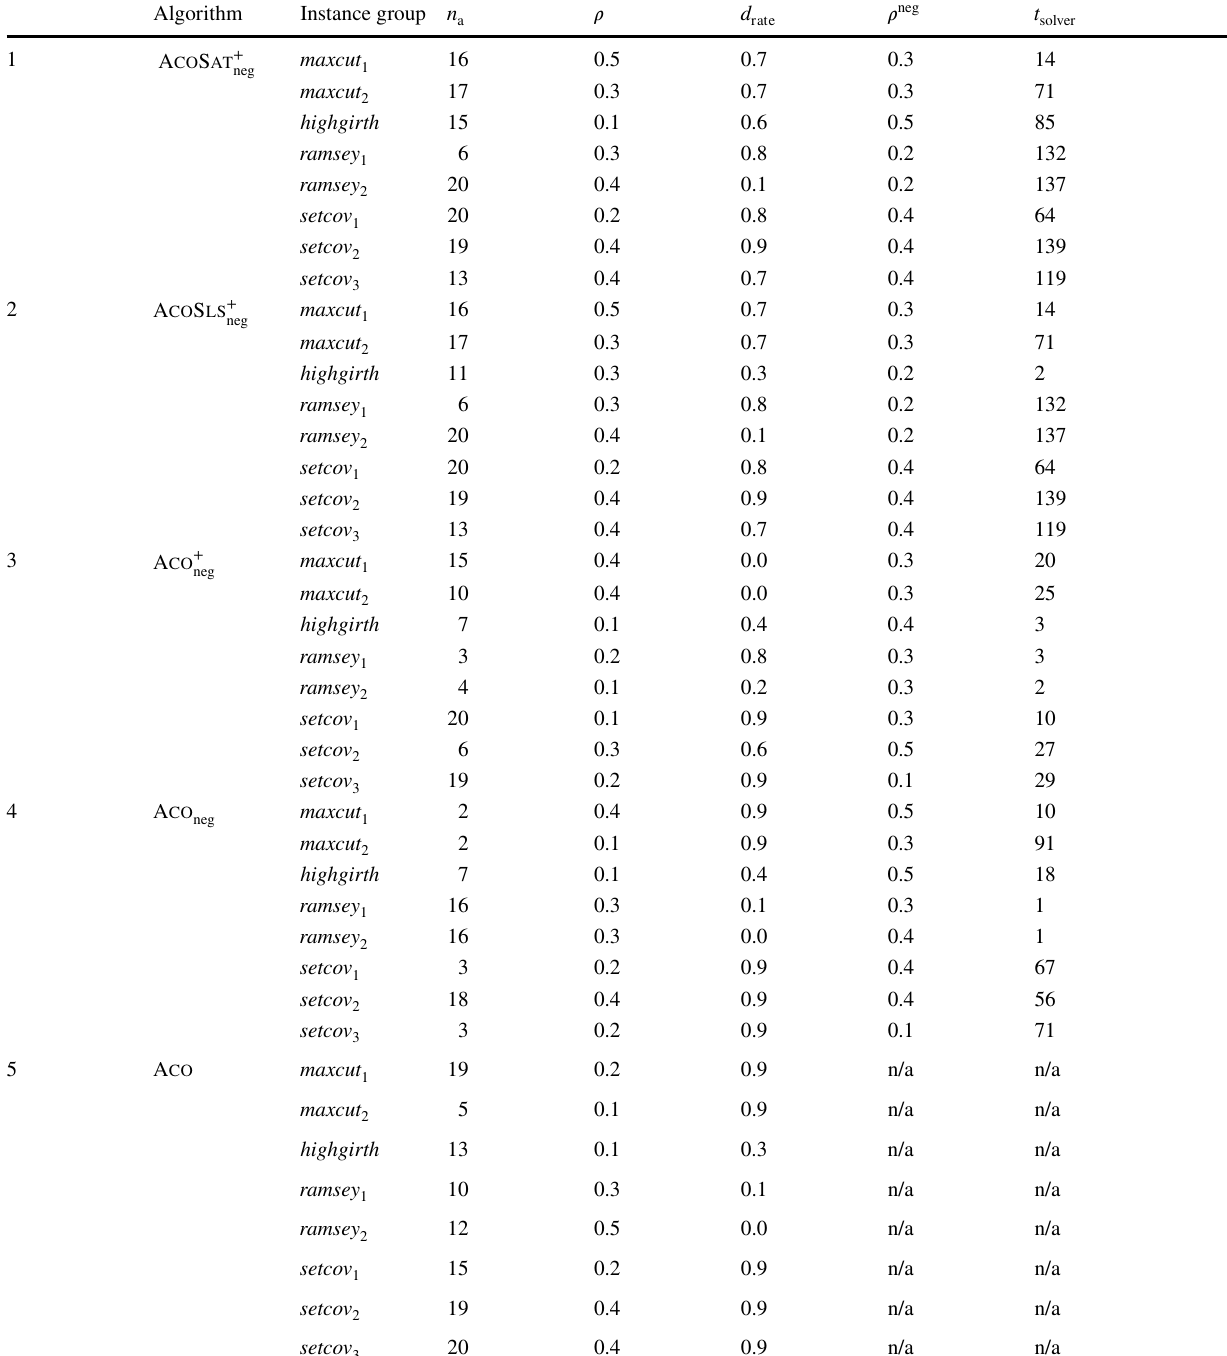
Table 10 Parameter values obtained for all A CO algorithms concerning MSE 2016 and 2020 instances Algorithm Instance group n